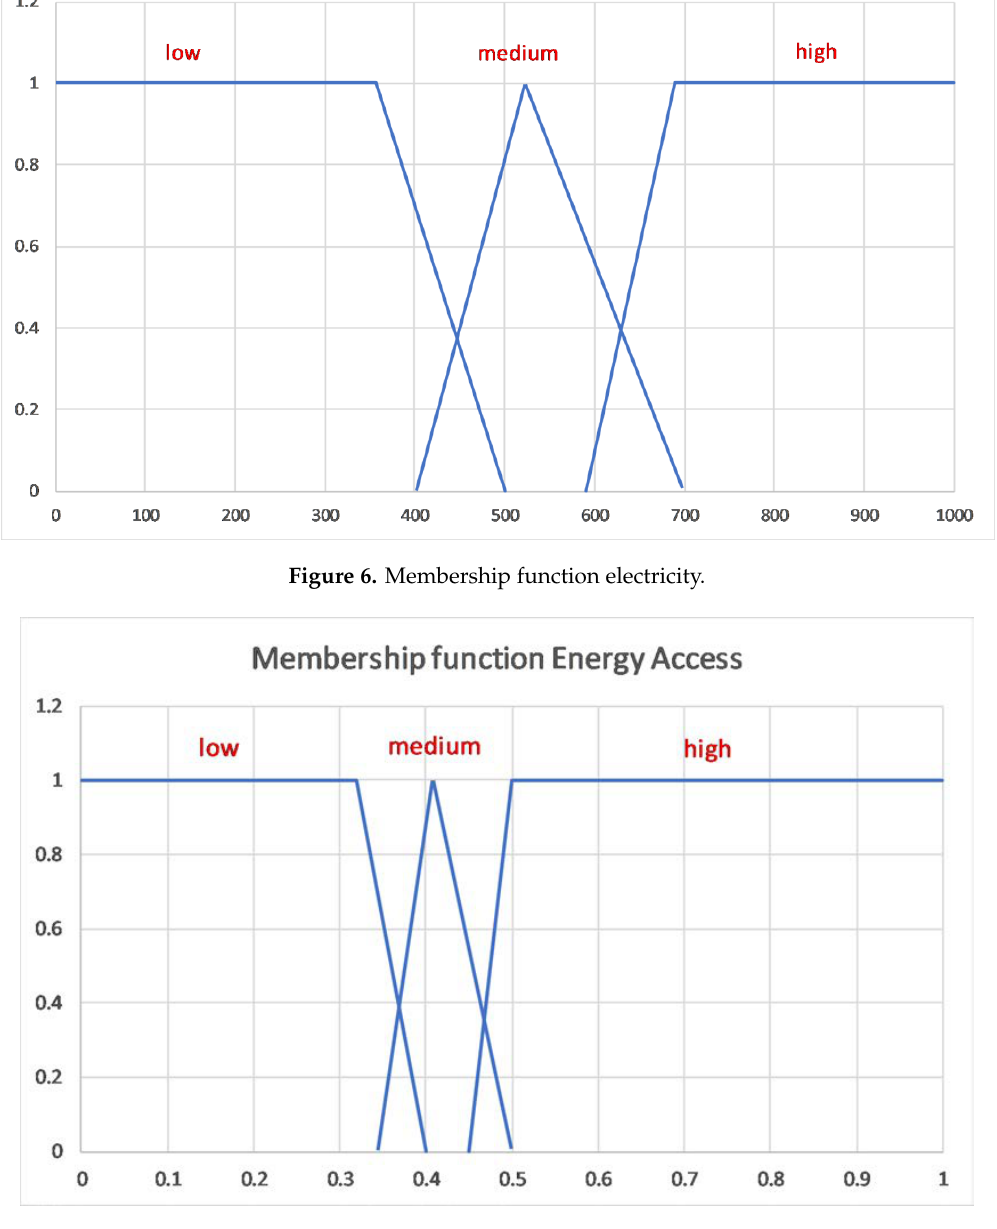
Figure 7. Membership function EA (Energy Access).